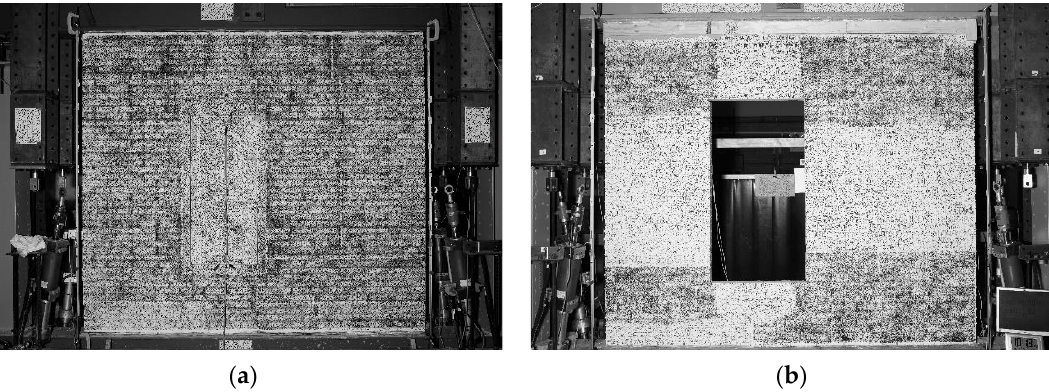
Figure 4. Front view of the in-plane walls with the DIC black-and-white pattern applied: ( a ) strengthened (TUD-COMP56) and ( b ) unstrengthened (TUD-COMP41) specimen where the glass and timber frame are also painted. Table 1. Overview of masonry properties.